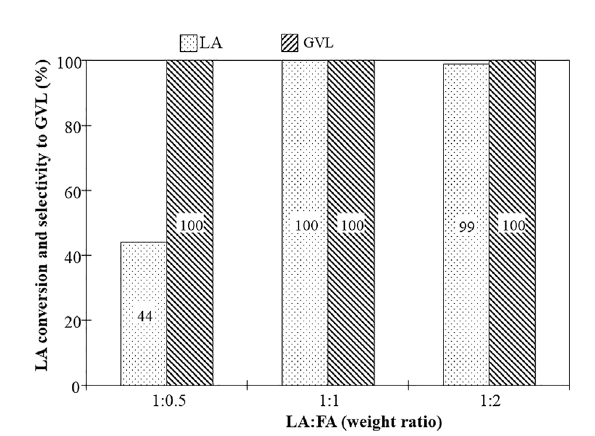
FIGURE 2 In fl uence of LA: FA ratio on LA conversion and GVL selectivity, reaction conditions: Catalyst-Mgo-UBE, temperature-250 ° C, liquid fl ow-0.015 mL/min, N2 fl ow-25 cc/min, catalyst weight-0.5 g